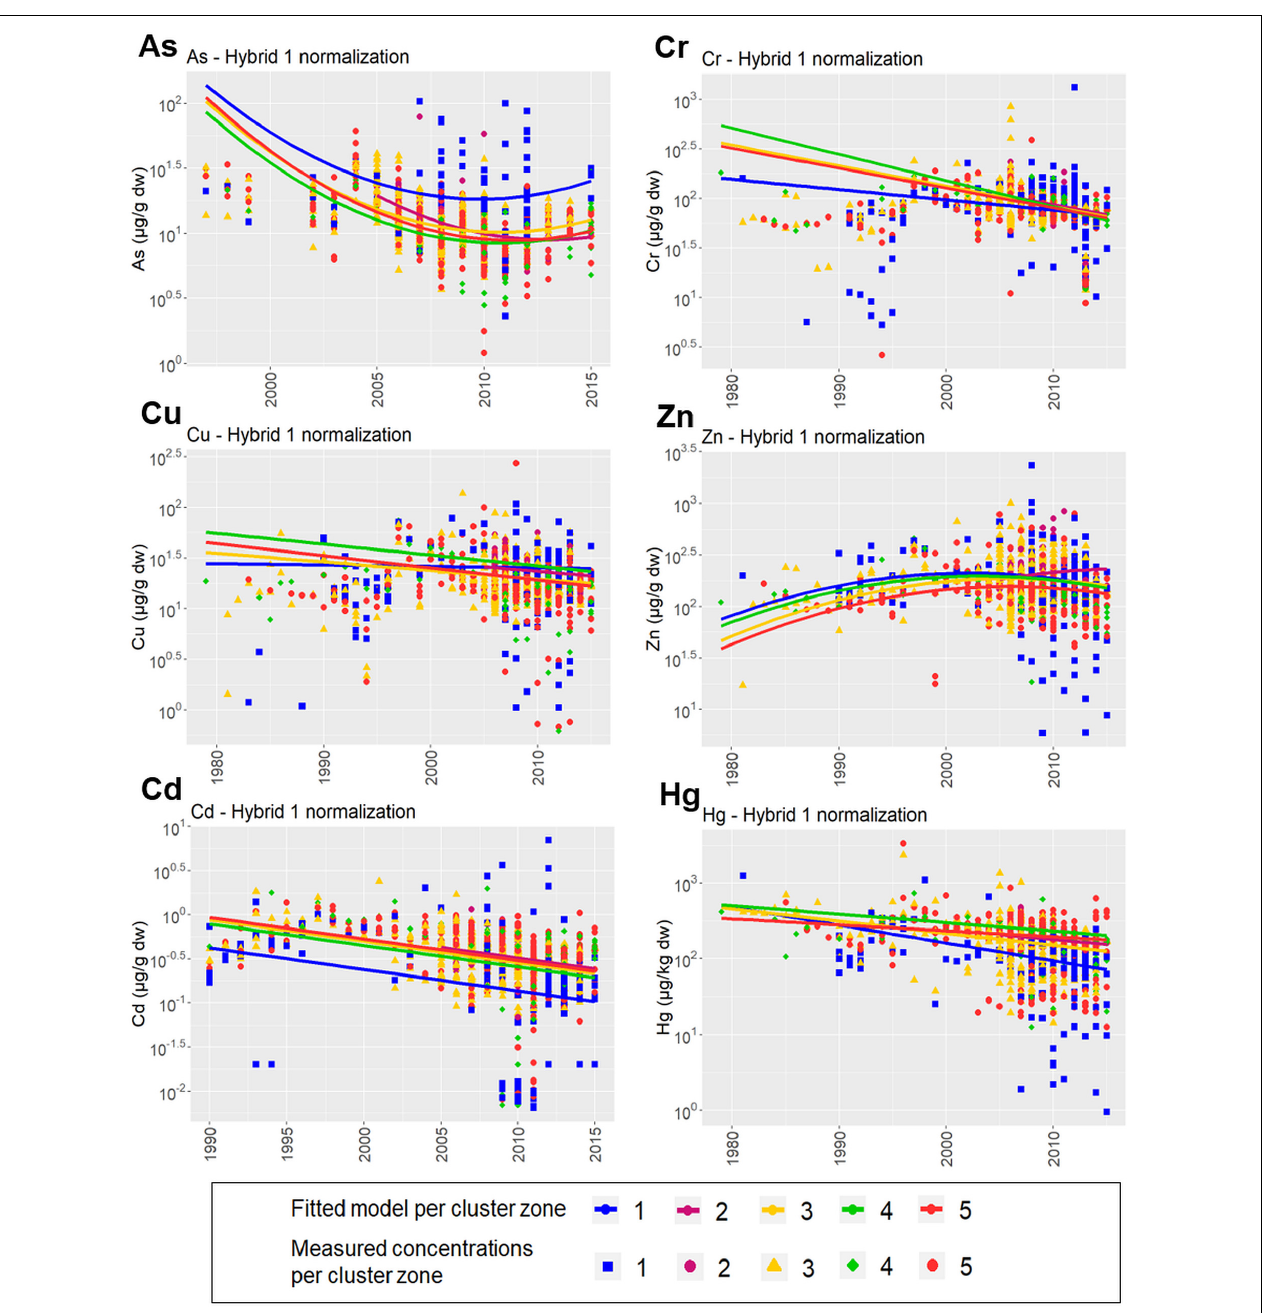
FIGURE 9 | Trends in metals in the BPNS based on Hybrid normalization method 1. Data points represent the derived concentrations after normalization. Colored regression lines represent the fitted time trends within each spatial cluster zone, scaled to the first quadrimester and to the most recent analytical method.